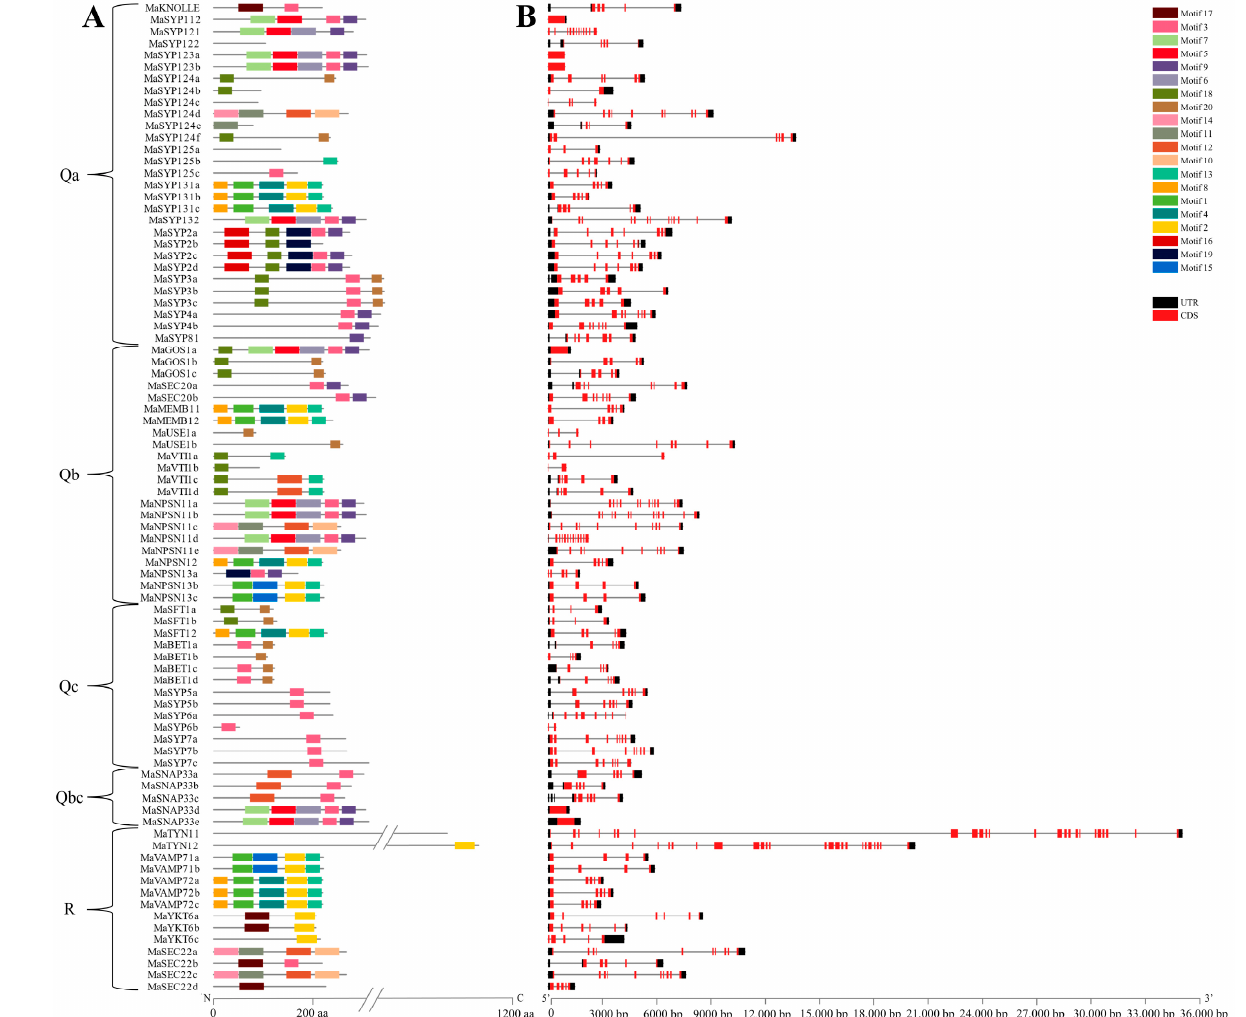
Figure 2. Conserved motifs ( A ) in MaSNAREs and gene structures of their encoding genes ( B ). Qa, Qb, Qc, Qbc and R represent five subfamilies of banana SNAREs.